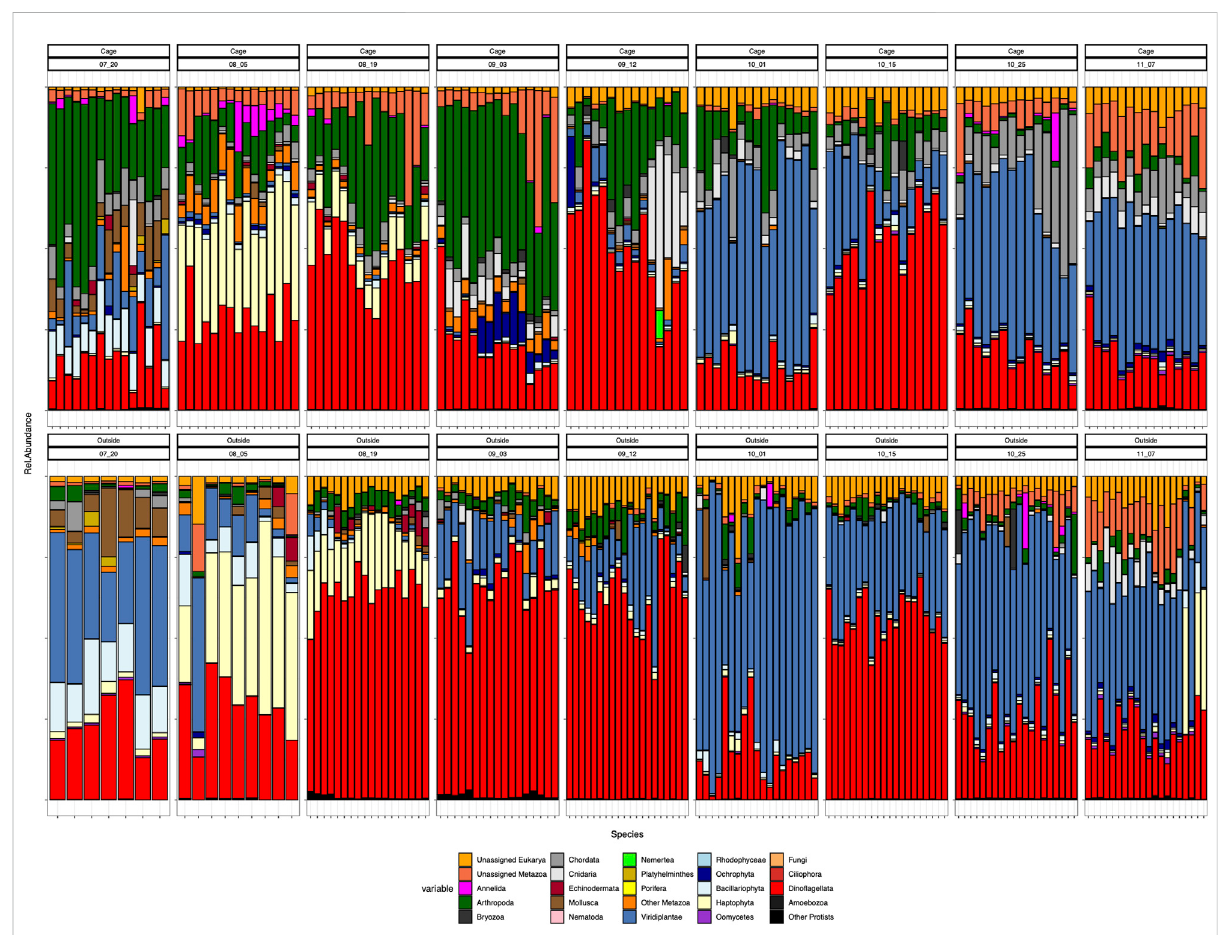
FIGURE 3 Composition at phylum level of all thesamples. Cage samples on top and Outside samples in the bottom: ordered by sampling date Each color represents a different